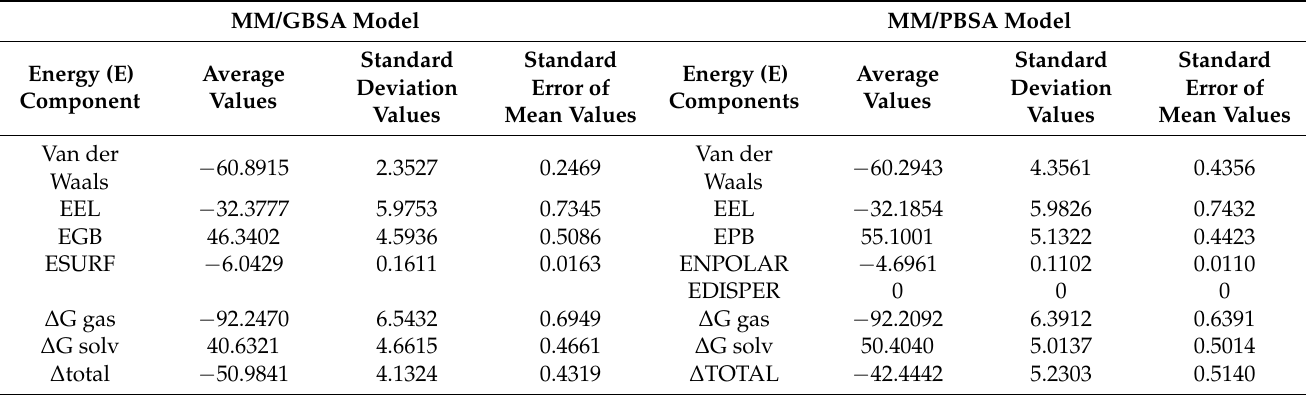
Table 6. Binding free energies of the COX-2 protein and selected potential bioactive compound